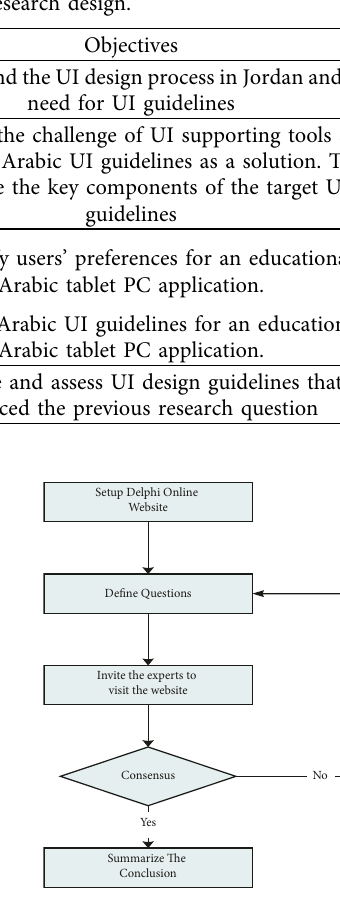
Figure 1: Flowchart of the Delphi